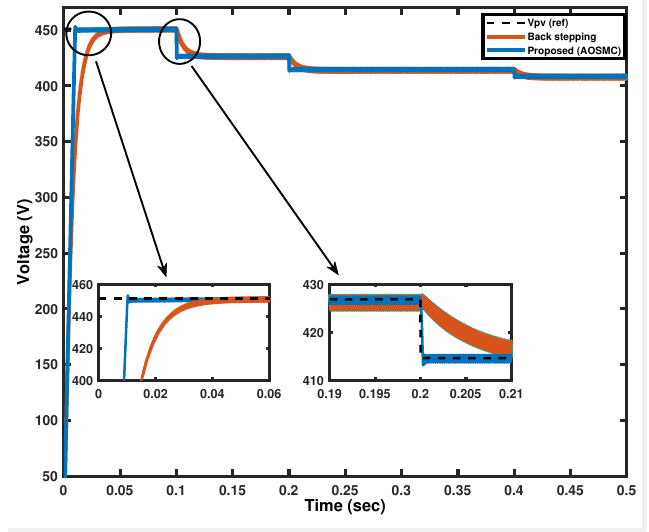
Figure 17. Comparison of voltage in PV system under varying irradiance.